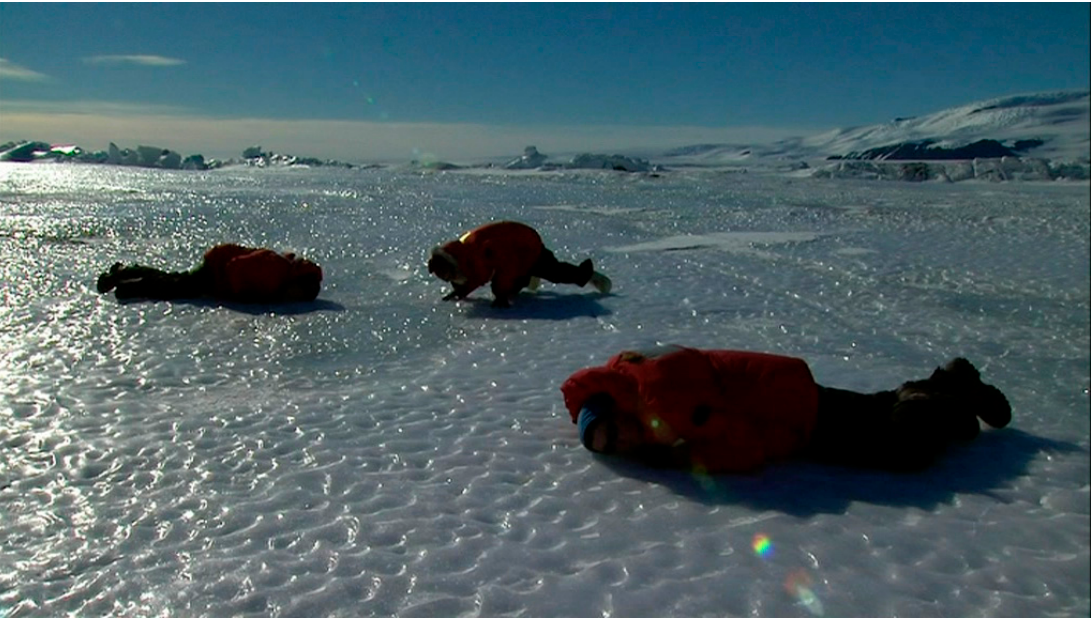
Figure 4. Nutrition physiologists listening to seals.